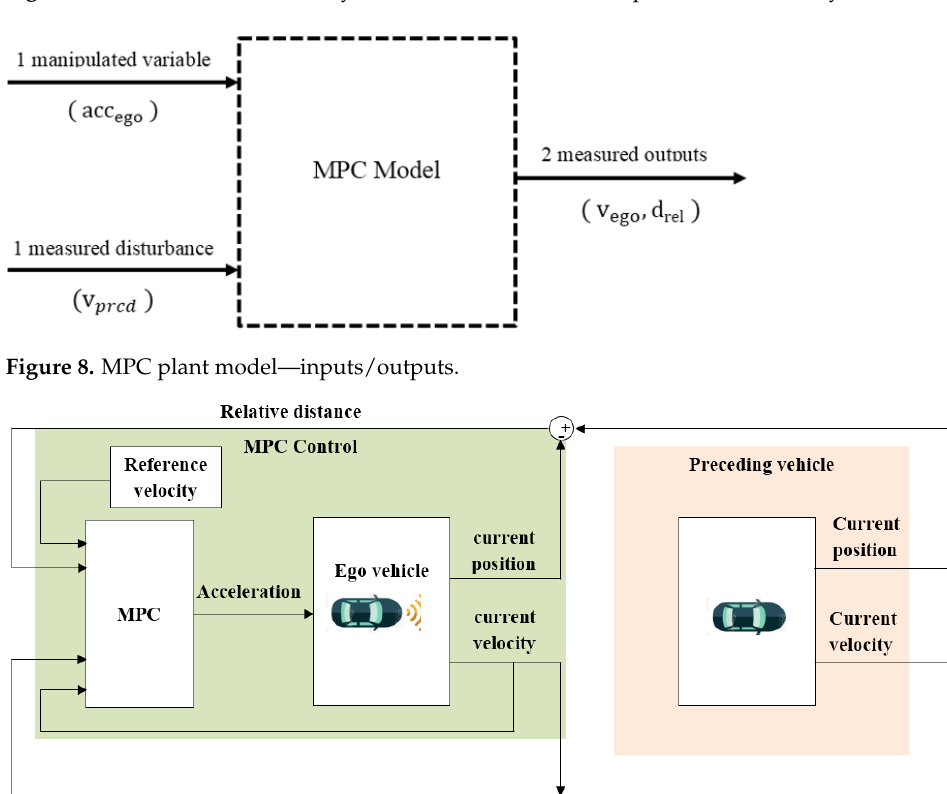
Figure 7. MATLAB simulink subsystem—vehicle model actual position and velocity.